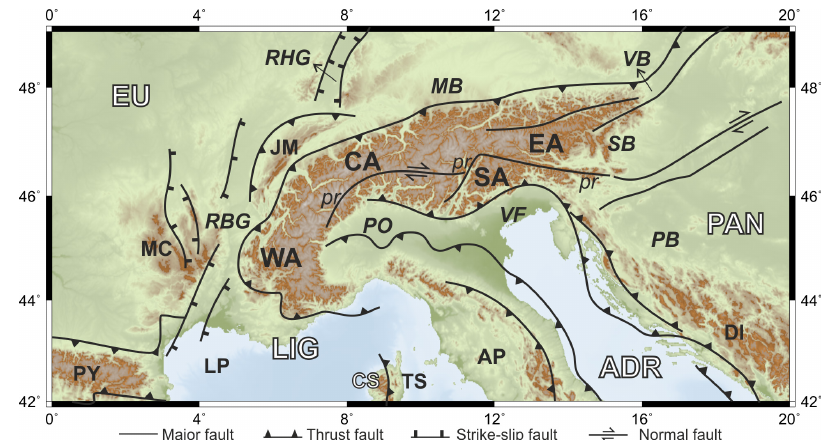
Figure 1. Simplified tectonic map of the Alps and surrounding areas showing the major tectonic features and faults, modified from Schmid et al. (2004) and Bousquet et al. (2012). Geographic subdivision of the Alps: WA – Western Alps, CA – Central Alps, EA – Eastern Alps, SA – Southern Alps. Tectonic plates/blocks: EU – Eurasia, ADR – Adria, LIG – Liguria, PAN – Pannonia, CS – Corso-Sardinia. Basins: LP – Liguro-Provençal, TS – Tyrrhenian, PO – Po, VF – Venetian-Friuli, MB – Molasse, PB – Pannonian, SB – Styrian, VB – Vienna. Graben: RBG – Rhône-Bresse, RHG – Rhine. Mountains and mountain belts: AP – Apennines, PY – Pyrenees, DI – Dinarides–Hellenides, JM – Jura, MC – Massif Central. Label pr identifies the Periadriatic Line. Topography and bathymetry after the ETOPO1 model (Amante and Eakins,